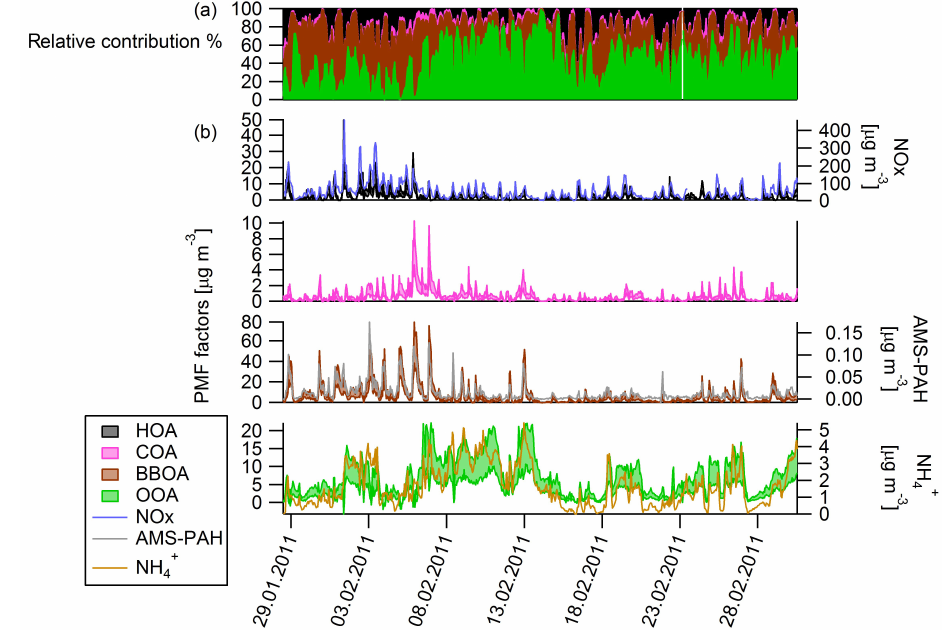
Figure 3. Online-AMS: (a) PMF factors relative contributions. (b) Time series of PMF factors and corresponding tracers. Shaded areas denote the model uncertainties.